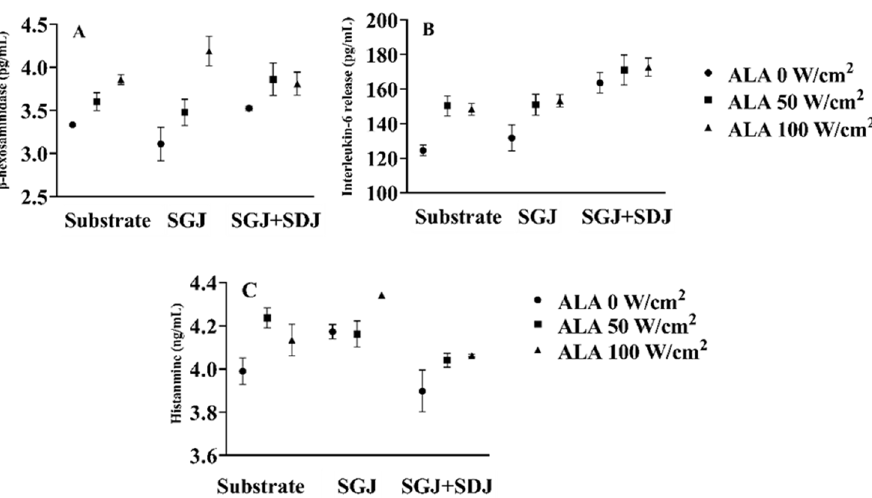
Figure 3. Influence of ultrasound treatment on the release of bioactive mediators. The release of β‐ Hex ( A ), the release of IL ‐ 6 ( B ), and the release of histamine ( C ). Substrate includes ALA ‐ 0, ALA ‐ 50, and ALA ‐ 100; SGJ is gastric digesta including ALA ‐ 0G, ALA ‐ 50G, and ALA ‐ 100G; SGJ+SDJ is gastroduodenal digesta containing ALA ‐ 0D, ALA ‐ 50D, and ALA ‐ 100D. SGJ: simulated gastric juice, SDJ: simulated duodenal juice. ALA ‐ 0: untreated ALA, ALA ‐ 50: ultrasound ‐ treated ALA at 50 W/cm 2 , ALA ‐ 100: ultrasound ‐ treated ALA at 100 W/cm 2 . ALA ‐ 0G, ALA ‐ 50G, and ALA ‐ 100G: ALA ‐ 0, ALA ‐ 50, and ALA ‐ 100 digested by simulated gastric juice. ALA ‐ 0D, ALA ‐ 50D, and ALA ‐ 100D: ALA ‐ 0, ALA ‐ 50, and ALA ‐ 100 digested by simulated gastric juice followed simulated duodenal